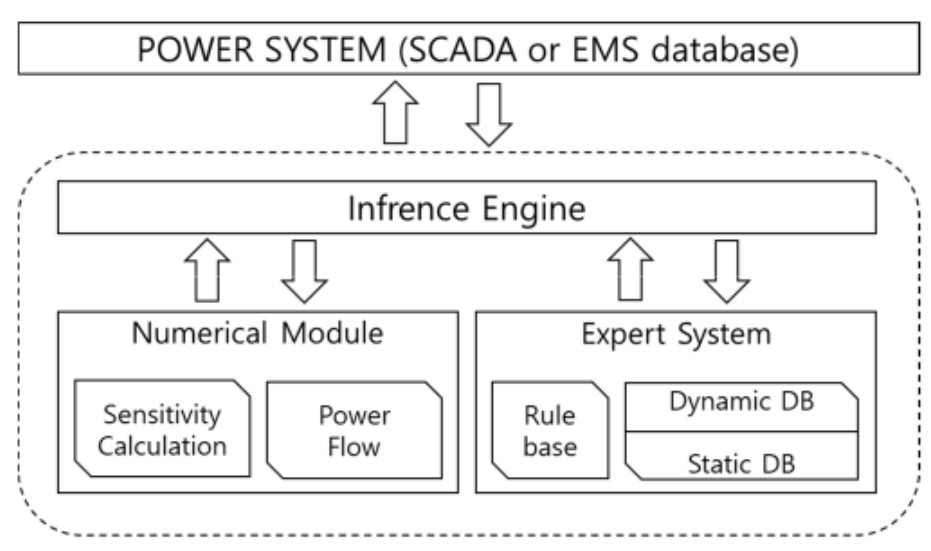
Figure 1. Structure of the proposed intelligent voltage control